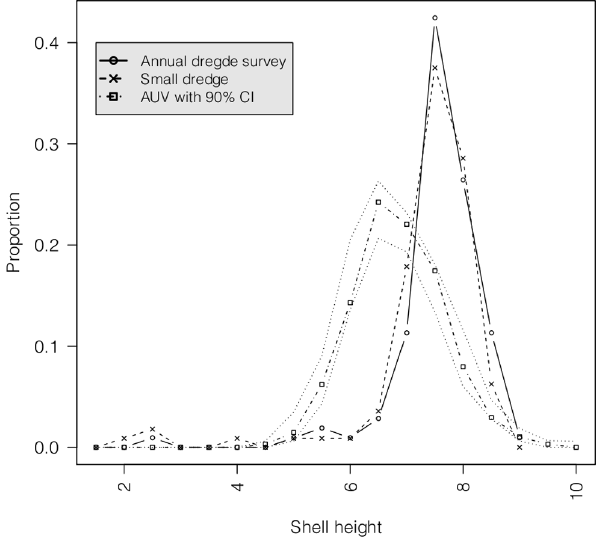
Figure 7. The proportional scallop shell height frequency distribution from the AUV survey with a 90% confidence bound (312 data points), the annual dredge tow (106 data points) and the small-scale dredge tow (112 data points).